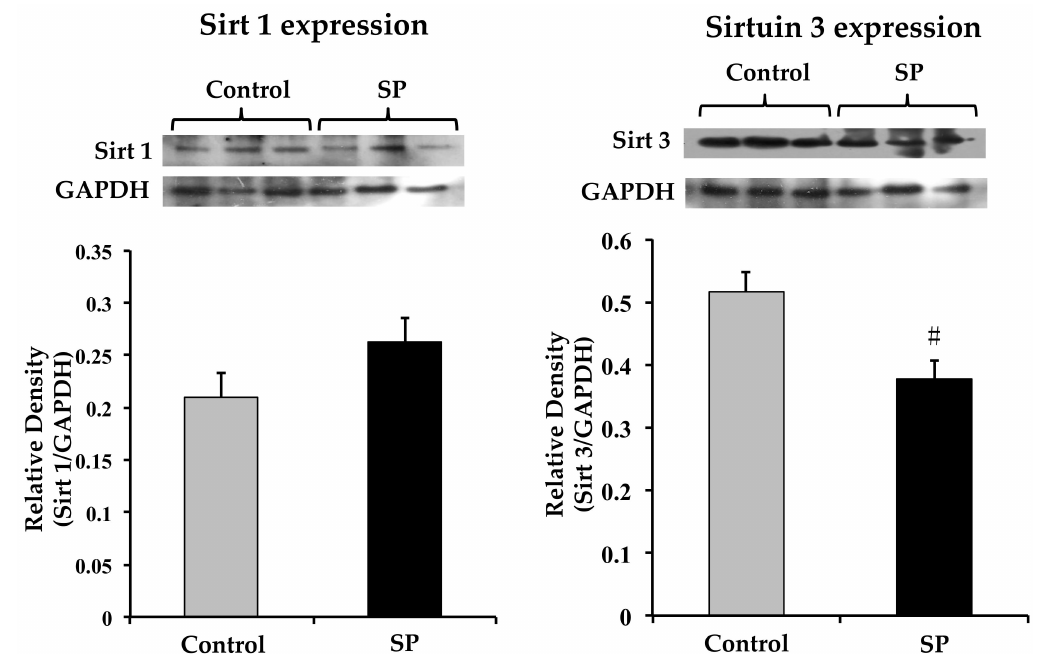
Figure 7. Sirt 1 and Sirt 3 expression in the homogenized tissue from the thoracic aorta from control and sucrose period rats. Data represent mean ± SEM, # p < 0.05, n = 4 (4 different homogenates from pools of 3 aortas from different rat pups and litters). A representative Western blot analysis is shown above the